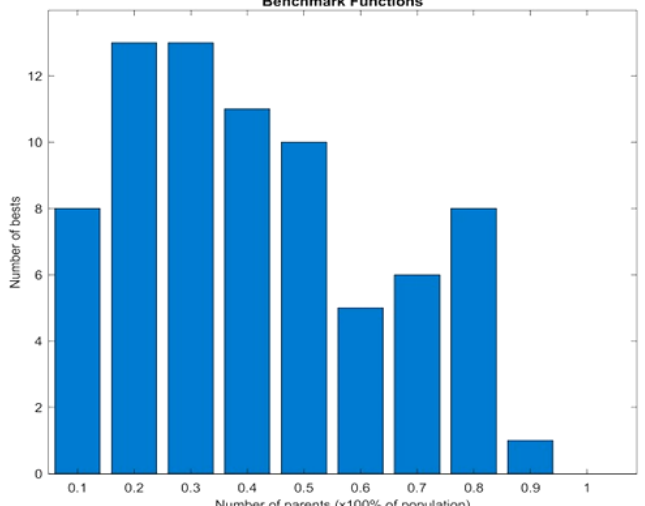
Figure 4. Effect of varying the parent size.